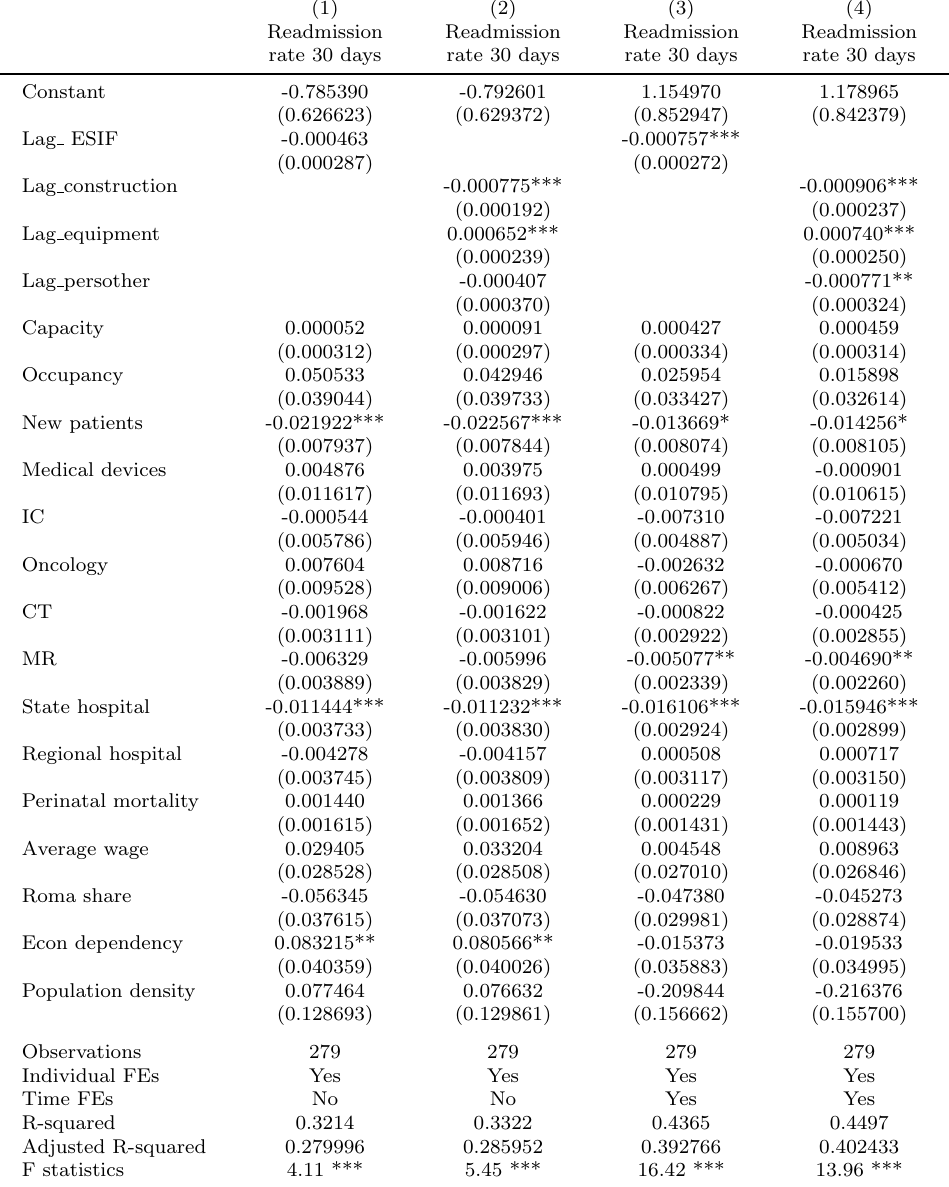
Table A.2: Lagged effect of cumulative ESIF on the readmission rate – full